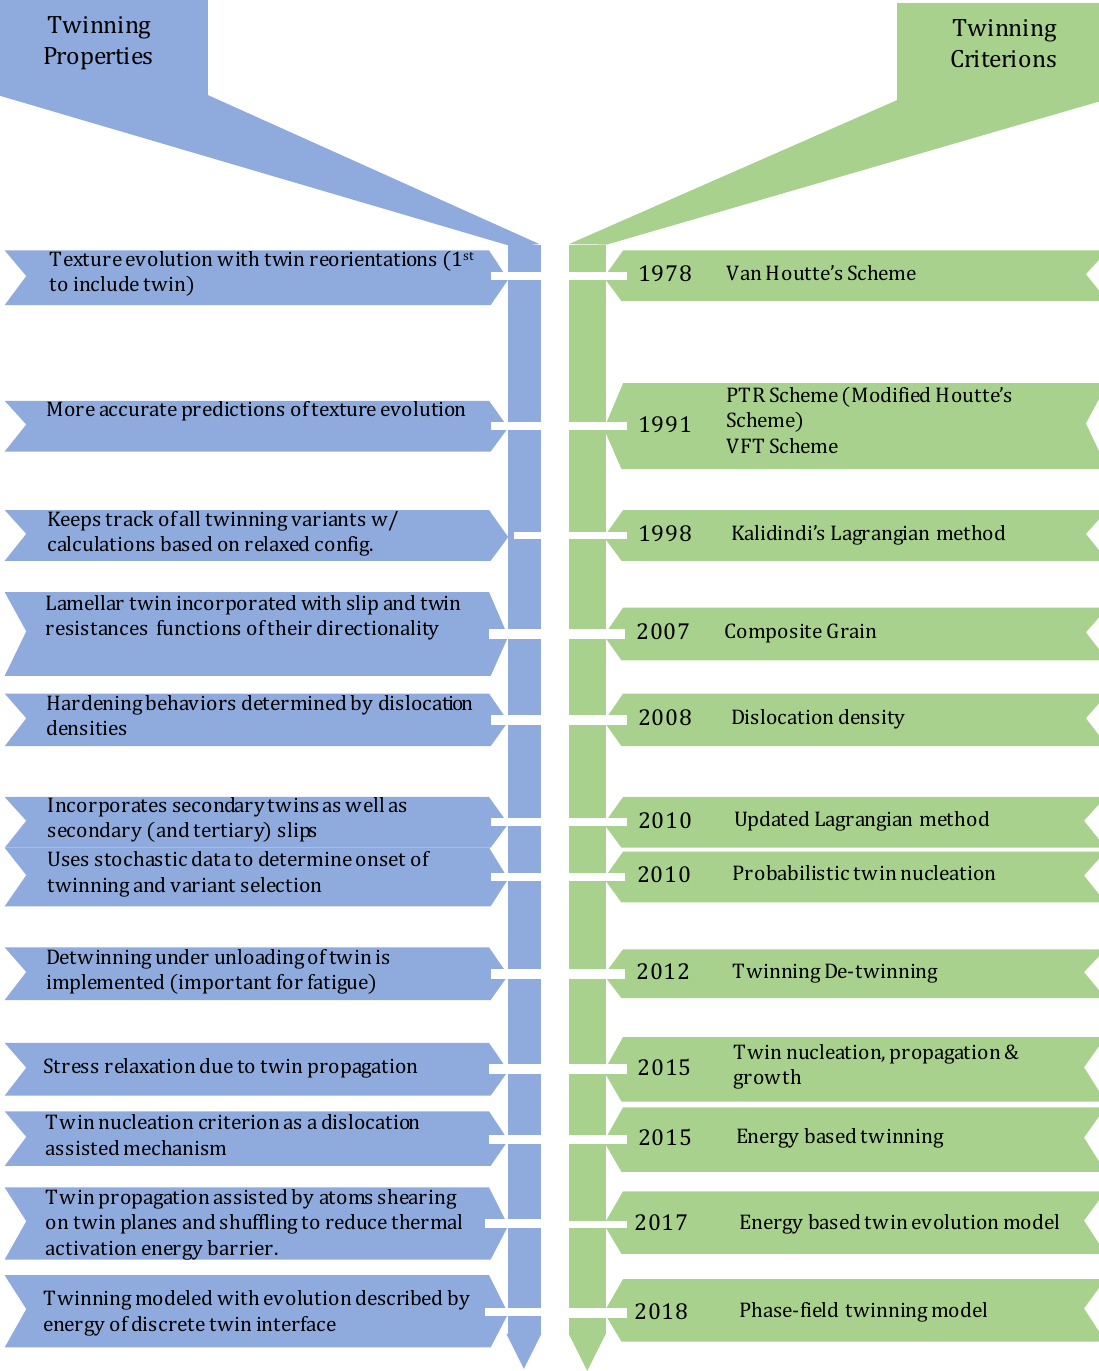
Figure 6. Timeline showing the incorporation of different twinning mechanisms through twinning criteria in crystal plasticity (CP)